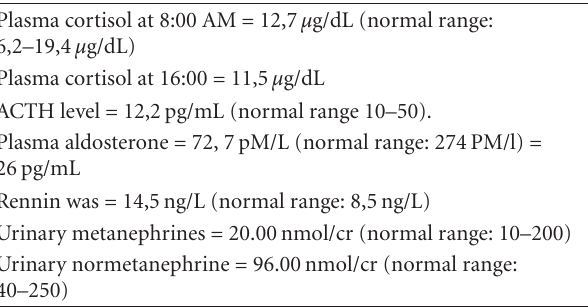
Table 2: Endocrinological data of our